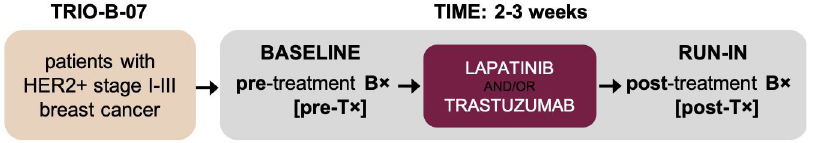
Fig 1. TRIO-B-07 neo-adjuvant HER2-targeted treatment course. Patients with HER2+ breast cancer underwent biopsies (B × ) before (baseline; pre-treatment; pre-T × ) and after (run-in; post-treatment; post-T × ) two to three weeks of HER2-targeted therapies (lapatinib; L and/or trastuzumab; T). The number of paired clinical samples available for RNA or protein analysis are described within Tables 1–4.